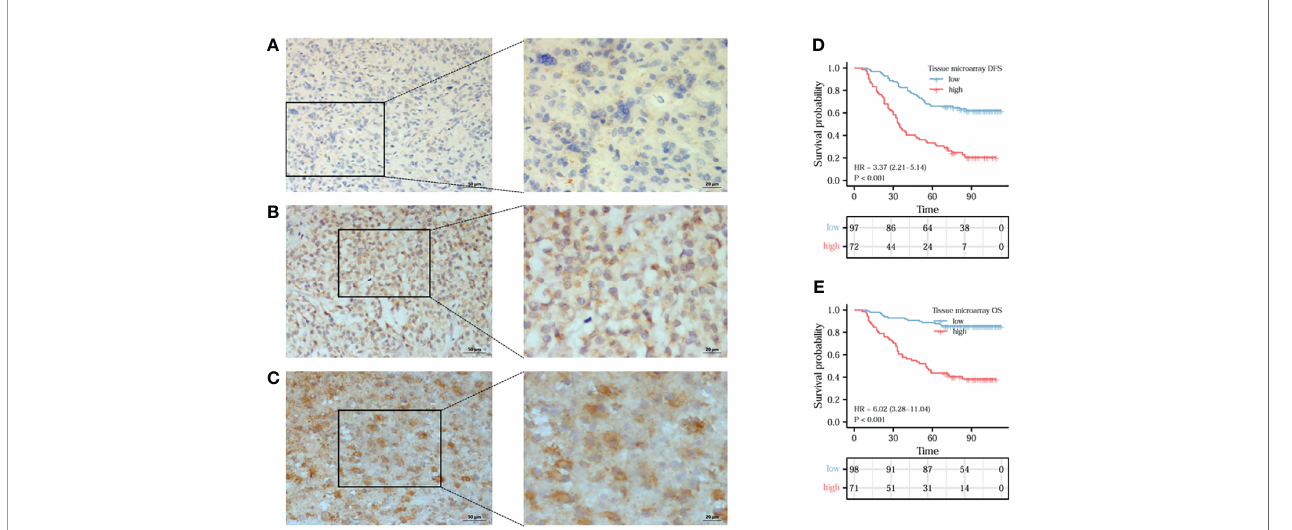
FIGURE 6 | The expression of cancer-derived immunoglobulin G (cancer-IgG) in gliomas and its prognostic signi fi cance were analyzed by immunohistochemistry. (A – C) Cancer-IgG is weakly, moderately, and strongly positive in gliomas, respectively. (D , E) A high cancer-IgG expression in glioma was Analysis of the TMA showed that disease-free survival (DFS) (HR = 6.02, 95%CI =3.28 – 11.04, p < 0.001) (D) and OS (HR = 3.37, 95%CI = 2.21 – 5.14, p < 0.001) (E) were obviously poorer in patients with a high expression of